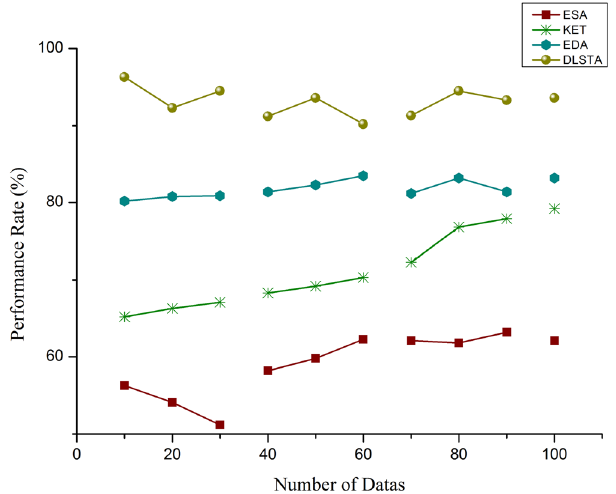
Figure 9: The performance rate of